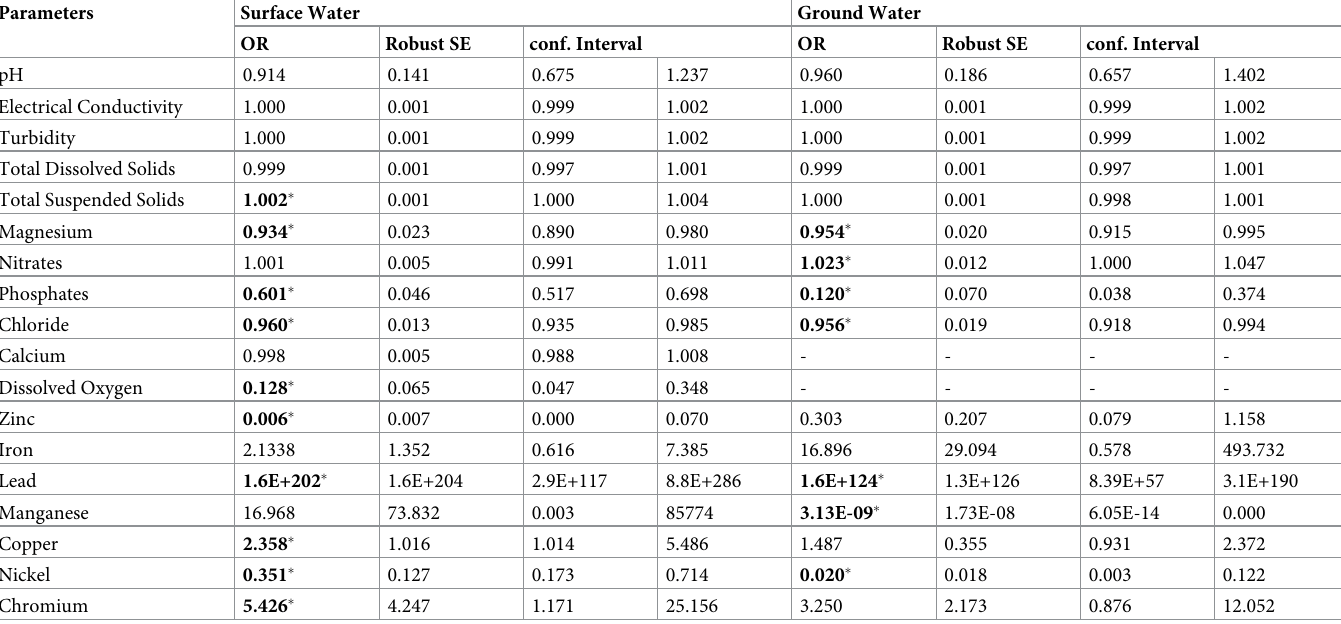
Table 3. Negative log-log bivariate regression of water quality parameters and faecal coliform bacteria.